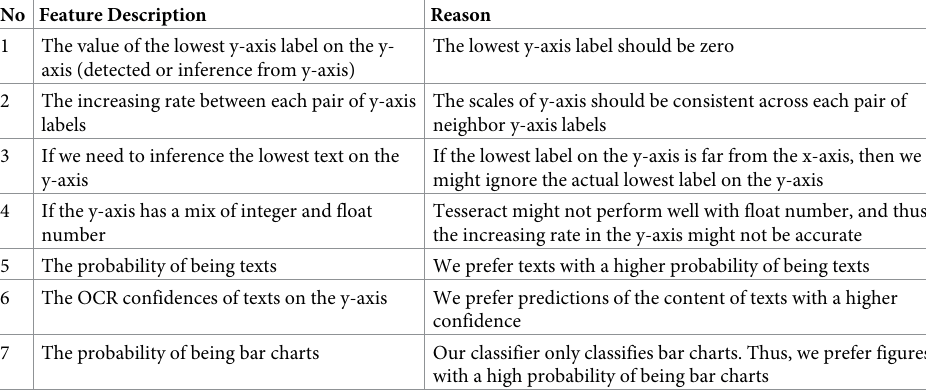
Table 2. Summary of features for proportional ink violation